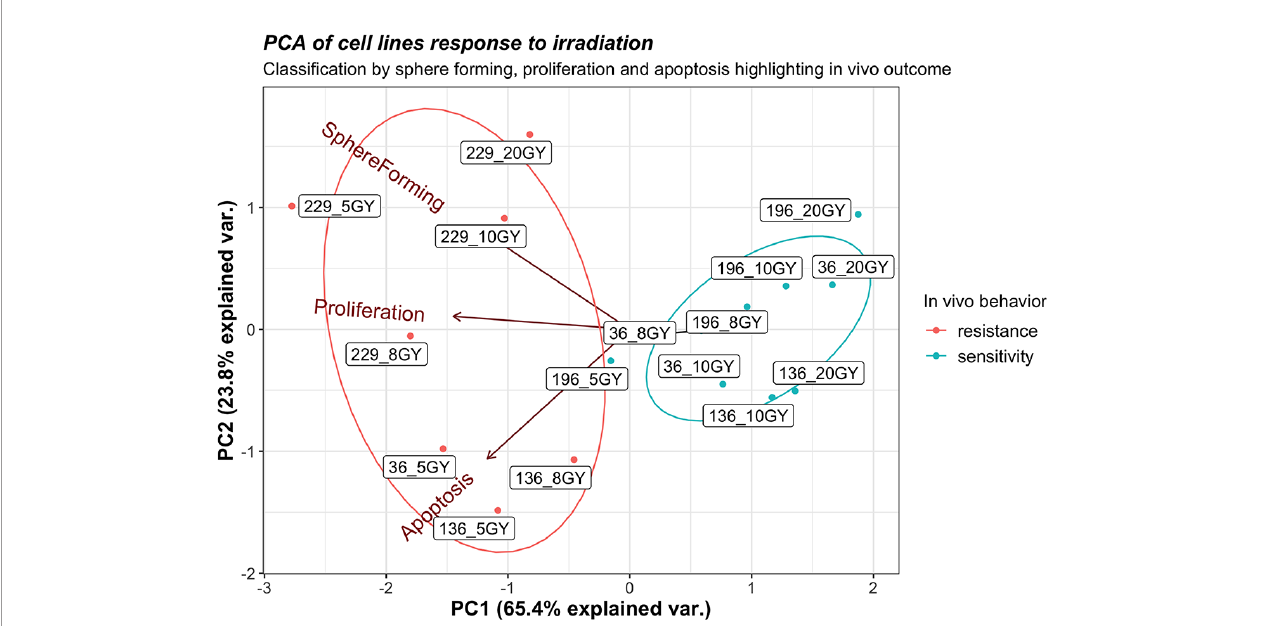
FIGURE 6 | Principal component analysis for sphere formation, proliferation, and apoptosis of all cell lines exposed to 2,400 MU/min at different gray (Gy) with in vivo response annotation. The label of each point identi fi es the cell line and the administered radiation dose (e.g., 196_10 identify line 196 exposed to 10